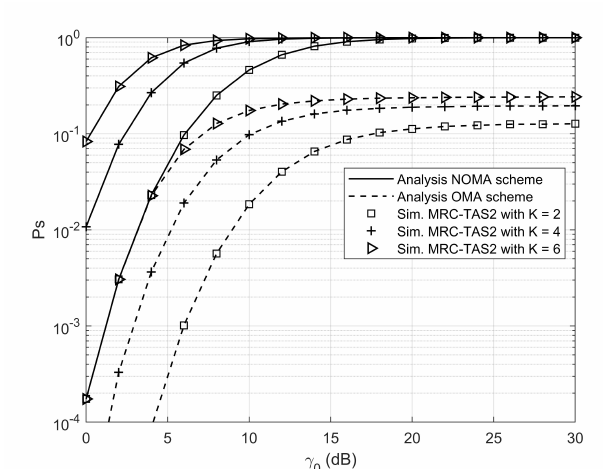
Figure 8. Impacts of the number of antennas K on Ps of MRC-MRT